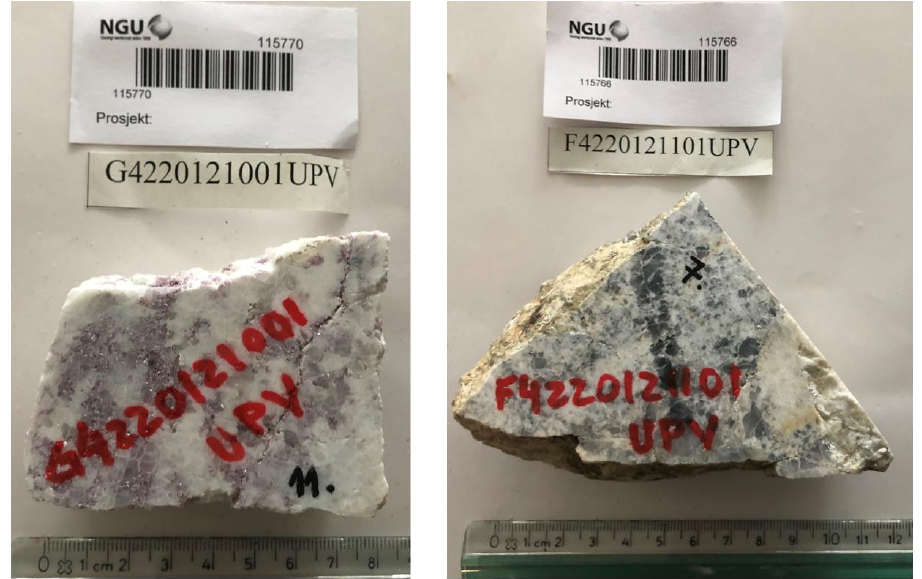
Figure 8. Photographs from LCT-type pegmatites from the Portuguese and Spanish sites. Left: Lepidolite pegmatite from Gonçalo, Portugal. Right: Petalite pegmatite from Hinojosa de Duero, Spain.